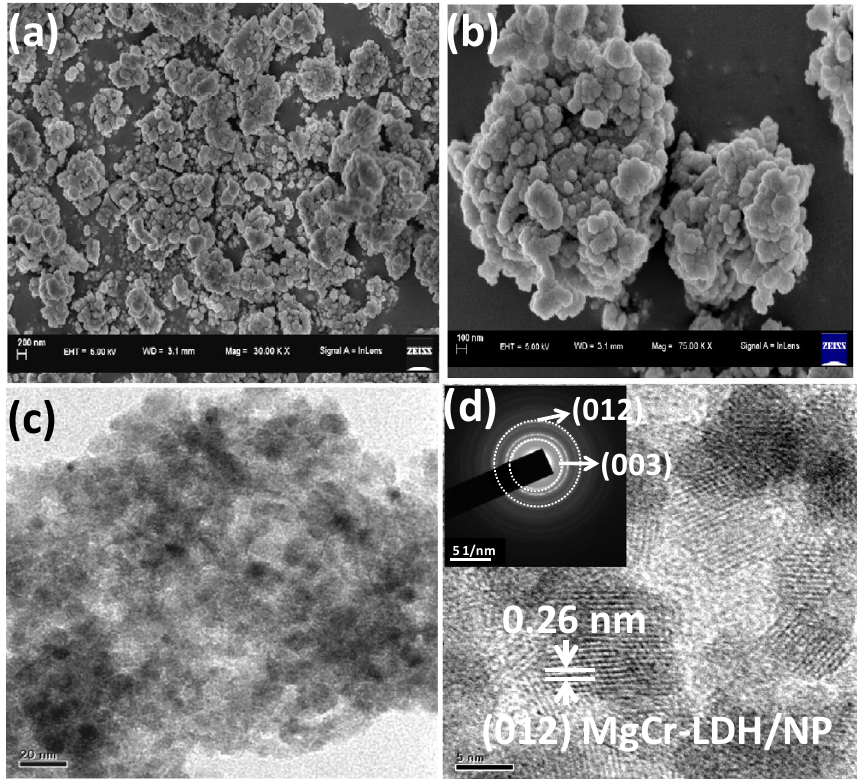
Figure 2. ( a , b ) FESEM morphology of MgCr-LDH/NP at different dimension, ( c ) TEM morphological features of MgCr-LDH/NP, and ( d ) lattice spacing of MgCr-LDH/NP as identified from HR-TEM image and corresponding SAED pattern (in-set image) of the material